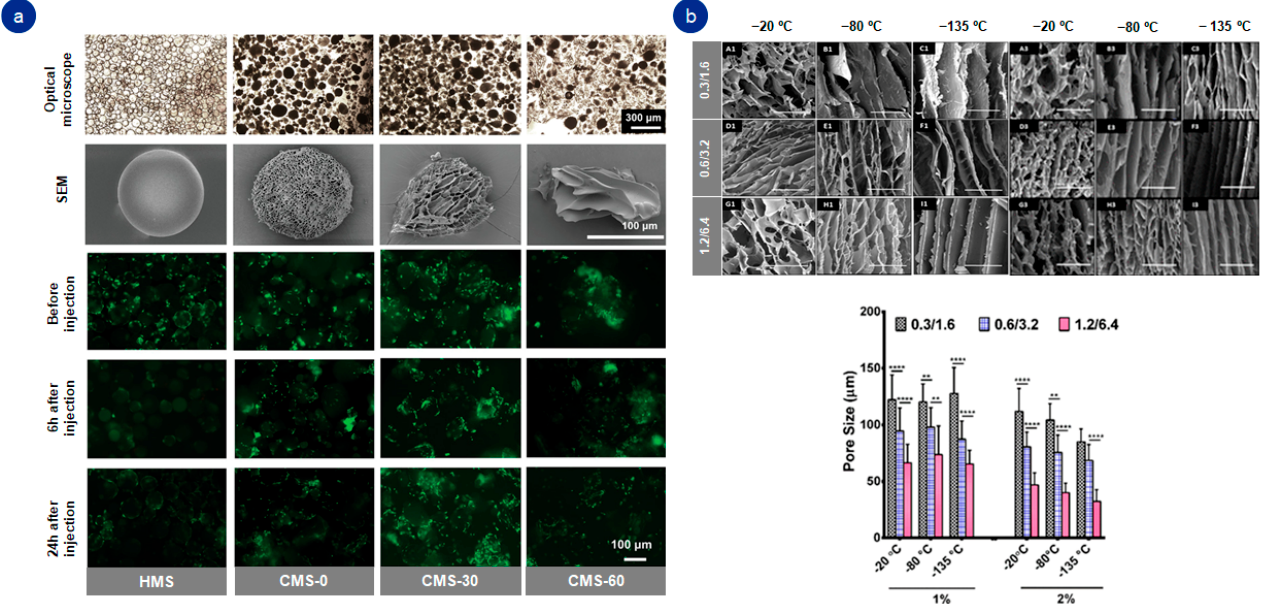
Figure 3. Effect of freeze-drying technique in gelatin-based systems: ( a ) macroscopic and microscopic (SEM) images of freeze-drying effect in gelatin-based hydrogels and viability assay of the cells within gelatin-based hydrogels; ( b ) SEM images and quantitative analysis of the effect of different temperatures and polymer concentration on pore size. ** p ≤ 0.01, **** p ≤ 0.0001. Adapted with permission from ( a ) Yuan et al. [47]. Small, published by John Wiley and Sons, copyright 2021; ( b ) Singh et al. [12]. Biomacromolecules 2019, 20 (2), 662–673. Copyright 2022, American Chemical Society.